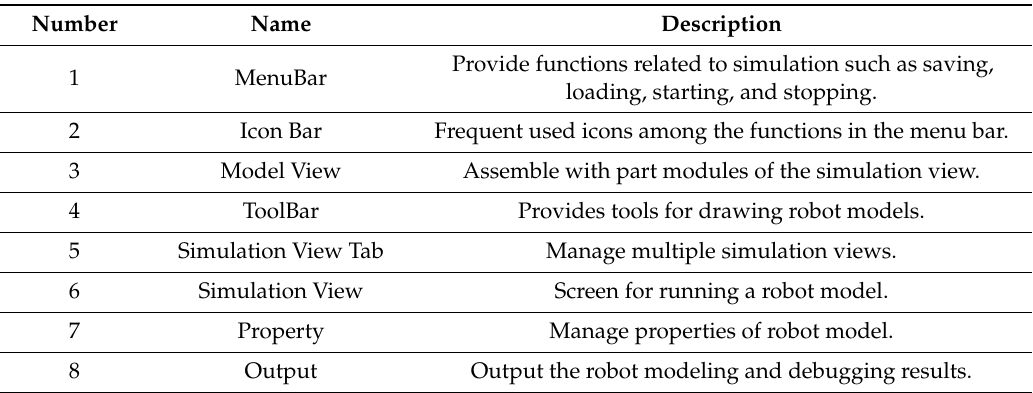
Table 5. Components of the smart tra ffi c control simulator.